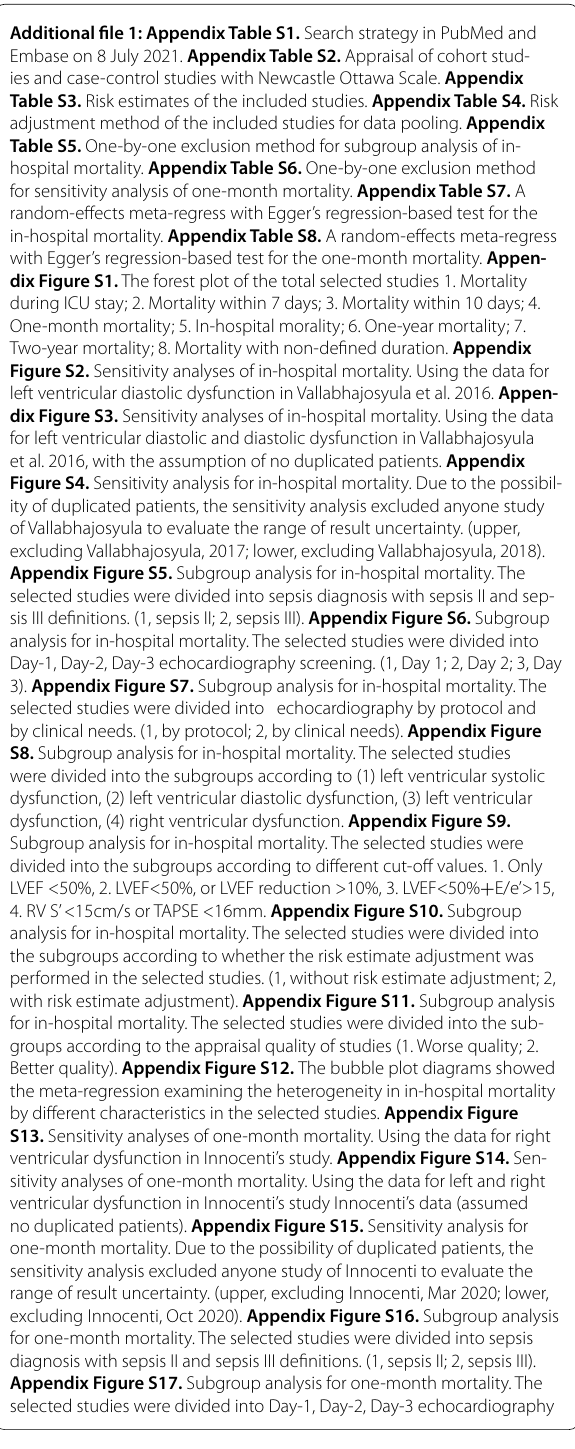
Figure S4. Sensitivity analysis for in‑hospital mortality. Due to the possibil‑ ity of duplicated patients, the sensitivity analysis excluded anyone study of Vallabhajosyula to evaluate the range of result uncertainty. (upper, excluding Vallabhajosyula, 2017; lower, excluding Vallabhajosyula, 2018). Appendix Figure S5. Subgroup analysis for in‑hospital mortality. The selected studies were divided into sepsis diagnosis with sepsis II and sep‑ sis III definitions. (1, sepsis II; 2, sepsis III). Appendix Figure S6. Subgroup analysis for in‑hospital mortality. The selected studies were divided